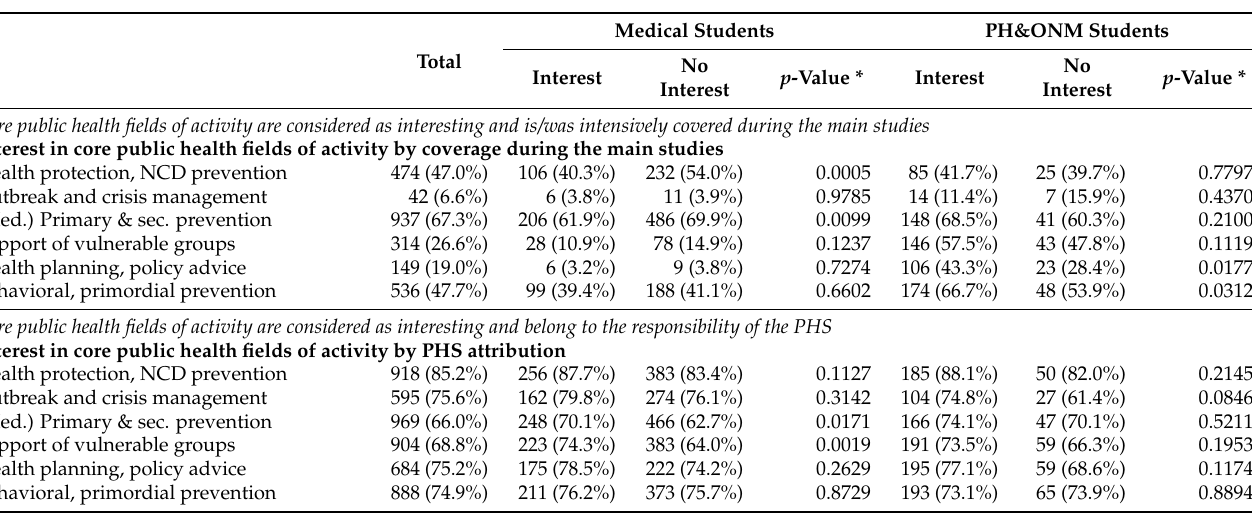
studies and attribution to the PHS: Absolute and relative proportions separated by medical